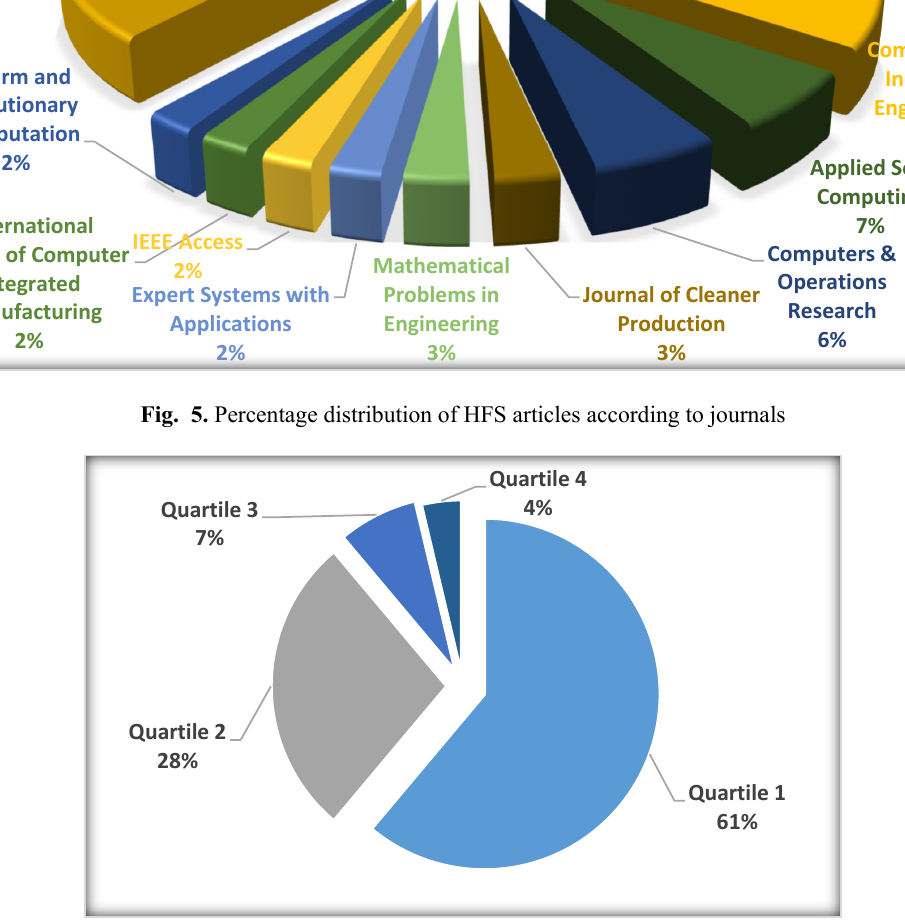
Fig. 6. Percentage distribution of journals according to SJR 2019 quartile